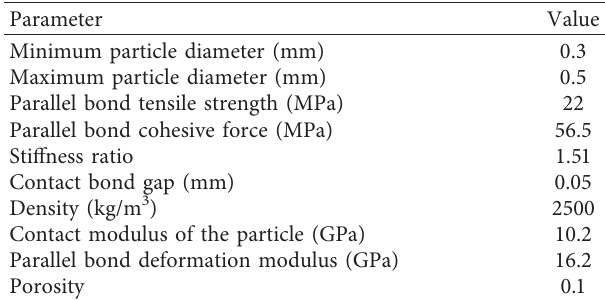
Table 1: Physicomechanical parameters of numerical test model.